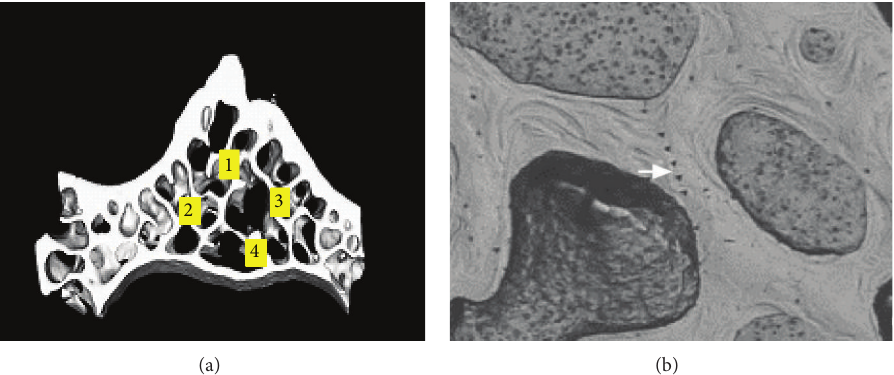
Figure 2: Schematic representation of the indent areas. On transversal slices of L6 vertebral body, nanoindentation test was performed randomly at four different regions (a). Five indentations were made for each site within 30–50 𝜇 m (b).